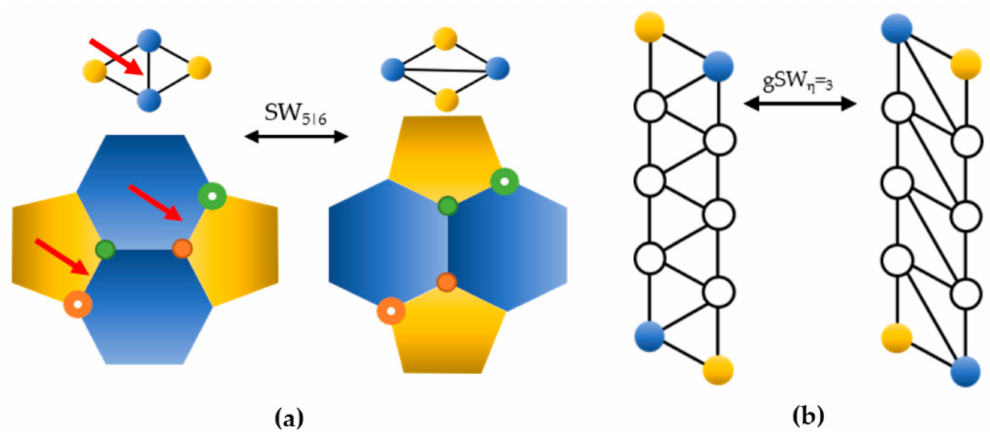
Figure 1. ( a ) Bottom Stone–Wales reversible transformation SW 5 | 6 on the fullerene direct graph G ; SW 5 | 6 rotates the central bond between green-orange pair. Red arrows indicate the bonds involved in the topological rearrangement. Top, SW 5 | 6 acting in the dual space G . ( b ) The generalized Stone–Wales reversible rotation gSW of order η = 3 in the dual space. In both cases, blue (yellow) elements represent hexagonal (pentagonal) rings; white circles may be hexagonal or pentagonal faces indi ff erently and they are preserved before / after the gSW rotation.